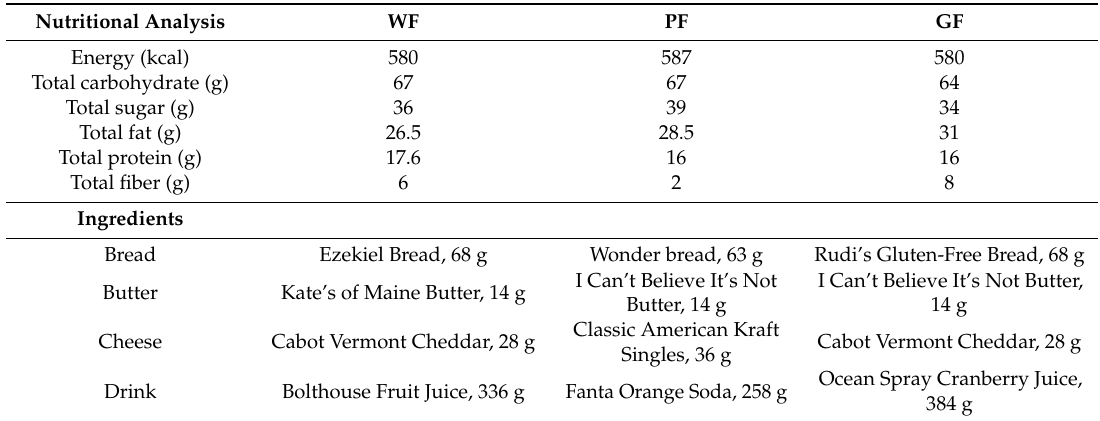
Table 1. Nutritional analysis and ingredients of the three test